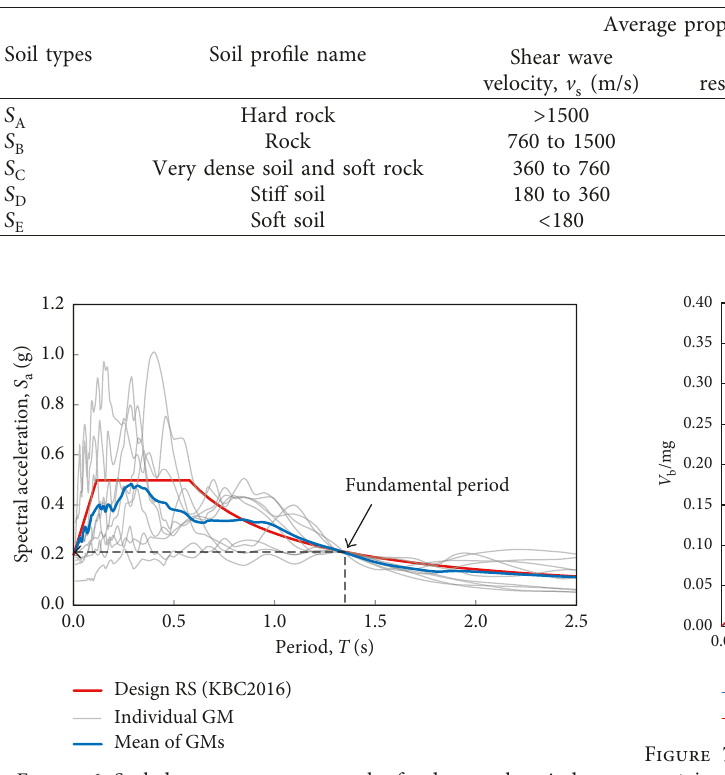
Figure 6: Scaled response spectra at the fundamental period.